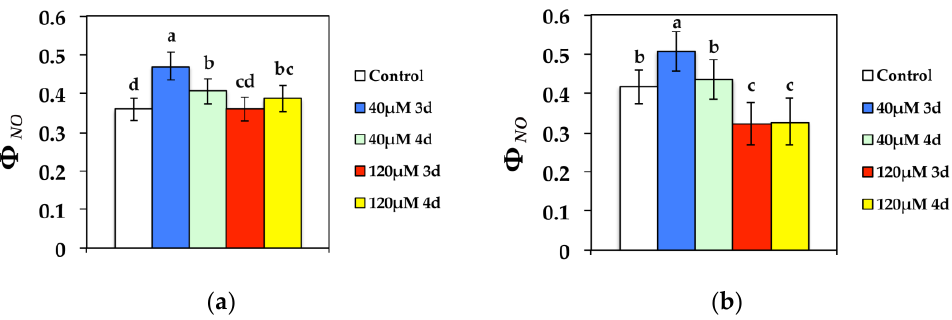
Figure 4. Changes in the quantum yield of non-regulated energy dissipated in PSII (non-regulated heat dissipation, a loss process due to PSII inactivity) ( Φ NO ) measured at ( a ) 300 µ mol photons m − 2 s − 1 or ( b ) 1000 µ mol photons m − 2 s − 1 . N. caerulescens plants were grown at 0 (control), 40, or 120 µ M Cd 2+ for 3 and 4 days.